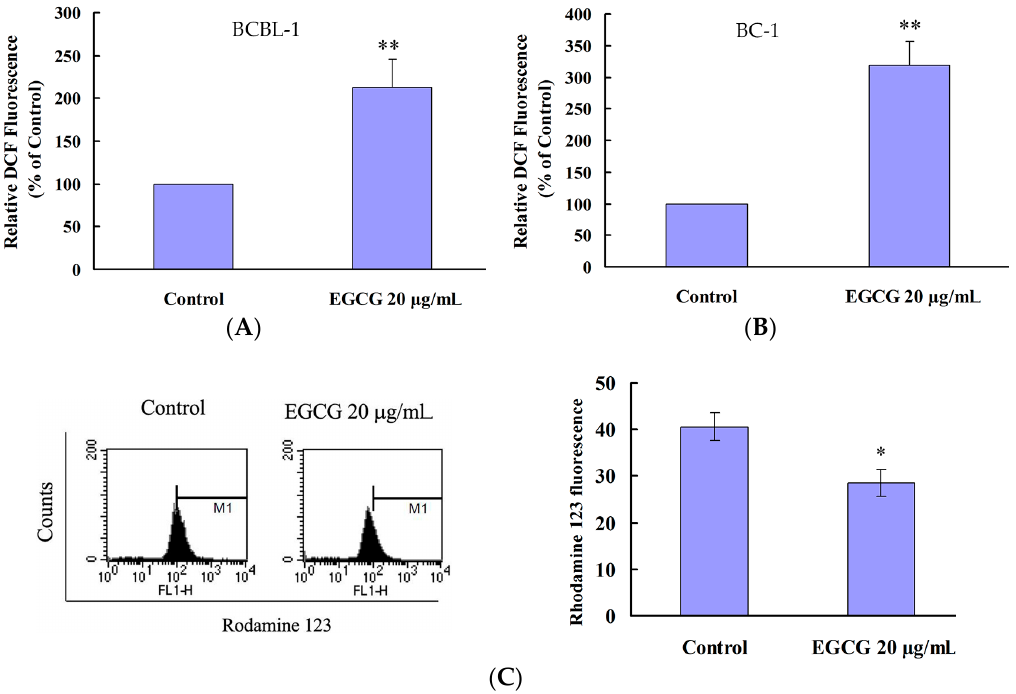
Figure 4. EGCG induced oxidative stress in HHV8-harboring PEL cells. ( A ) BCBL-1 and ( B ) BC-1 were treated with 20 μ g/mL EGCG for 24 h. ROS generation was detected by staining with H 2 DCFDA; ( C ) The mitochondrial membrane potential (MMP) was monitored by staining with Rh123 dye. Results are expressed as mean Rh123 fluorescence. The representative data are shown. The values represent mean ± SE of three independent experiments and are presented as the percentage of the control. * p < 0.05 and ** p < 0.01 indicate significant differences between the control and EGCG-treated cells.